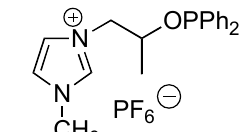
Figure 4. Imidazolium based phosphinite